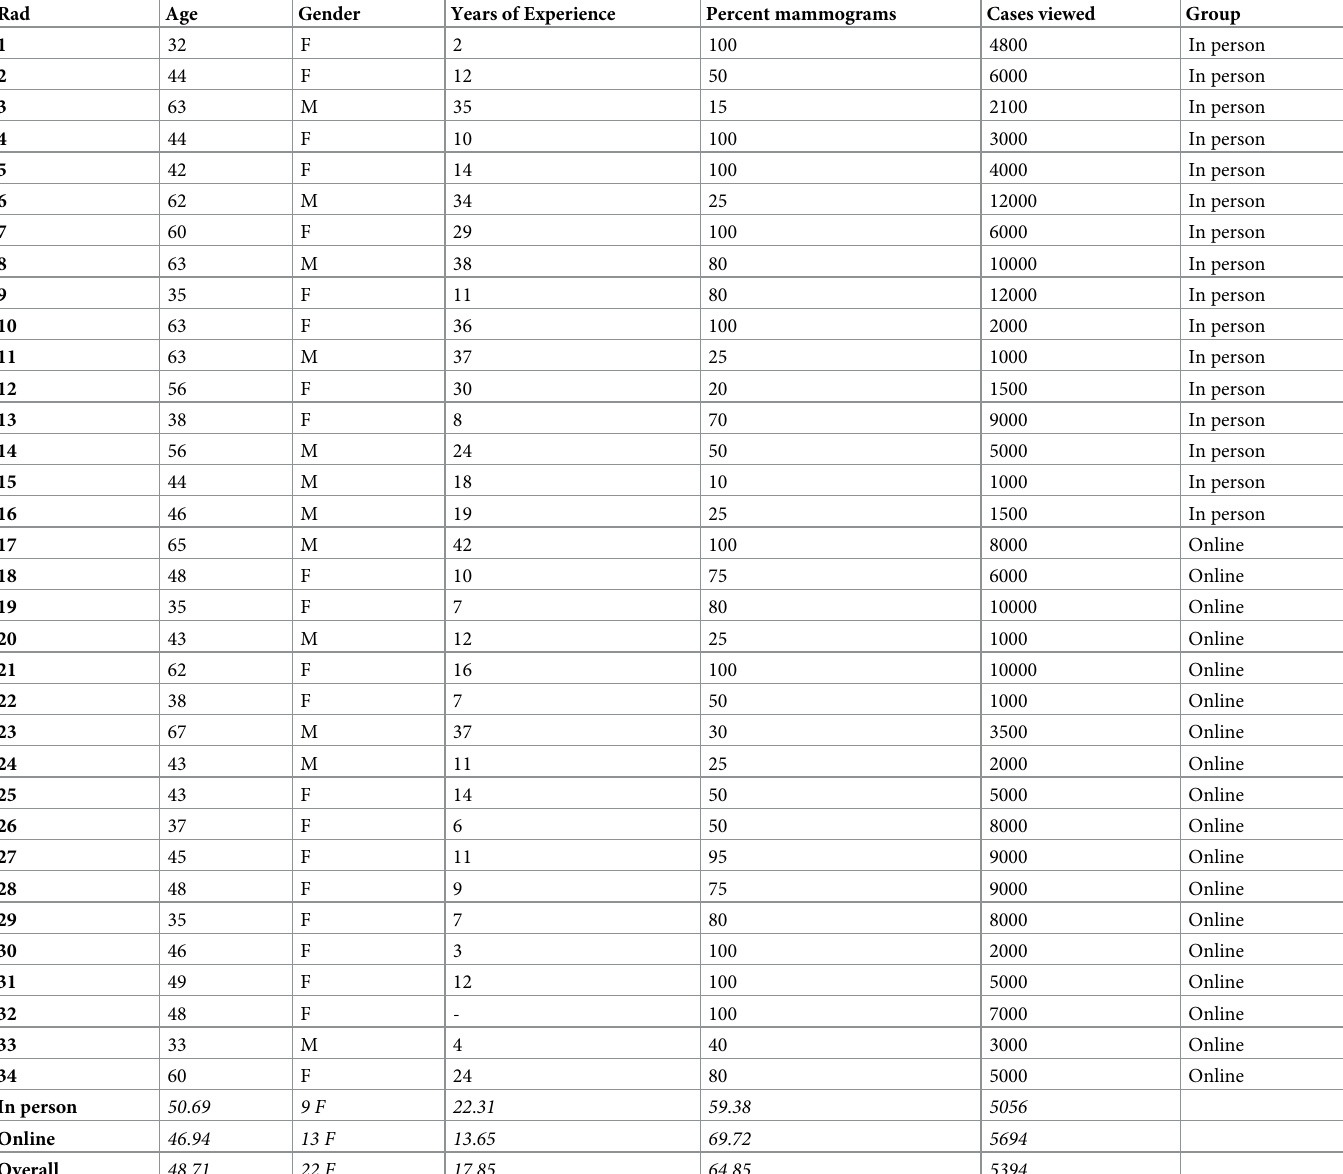
Table 1. Demographics for each participating radiologist. The table shows the age, gender, years of experience, percent of cases viewed that were mammograms, and number of cases viewed in the previous